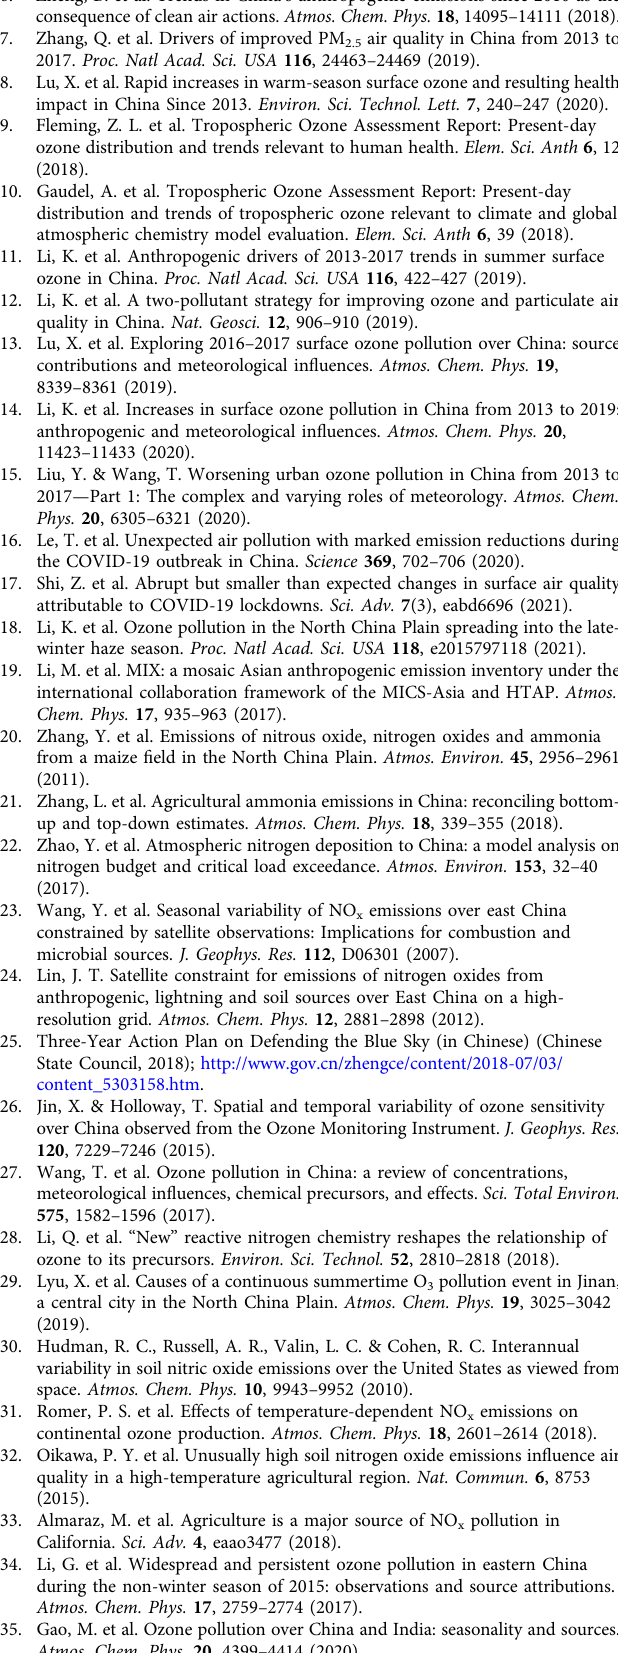
Supplementary Table 1. Modeling outputs and data generated in this study have been deposited in https://doi.org/10.5281/zenodo.4740433 66 and is publically